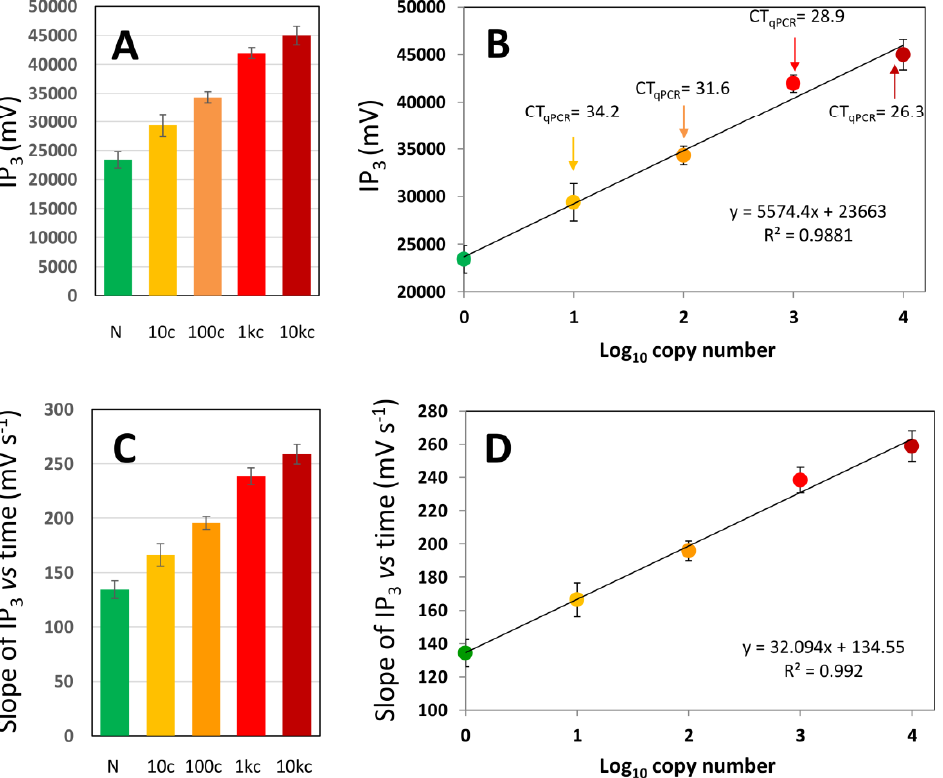
Figure 5. Results from the online evaluation of electric potential in five saliva samples from volunteers diagnosed as SARS-CoV-2 negative (green symbols) and a sets of five saliva samples added with 10 (yellow), 100 (orange), 1000 (red), and 10,000 copies (burgundy symbols) of SARS-CoV-2 genetic material. ( A ) Value of the integral of the differential of potential with respect to time for the first 3 min of amplification (defined here as IP 3 value) in saliva samples containing different copy numbers of synthetic SARS-CoV-2 genetic material in the range of 10 – 10,000 copies (yellow, orange, red, and burgundy bars) or not containing SARS-CoV-2 genetic material (green bar). ( B ) A correlation exists between the number of synthetic N gene copies of SARS-CoV-2 in the sample and the IP 3 value. The corresponding cycle threshold (CT) values, as determined by qPCR, are indicated with arrows. ( C ) Value of the slope of the plot of IP 3 versus time for the same set of samples; ( D ) a correlation also exists between the slope of the IP 3 time plot and the gene copy number in the sample. In all cases, data from at least four independent runs were analyzed. Error bars indicate standard deviations.